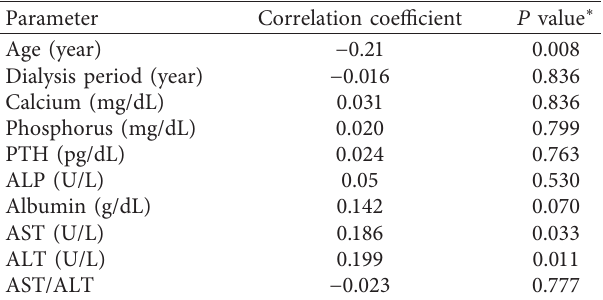
Table 4: Spearman’s correlation of 25 (OH)D levels and various clinical and biochemical parameters.